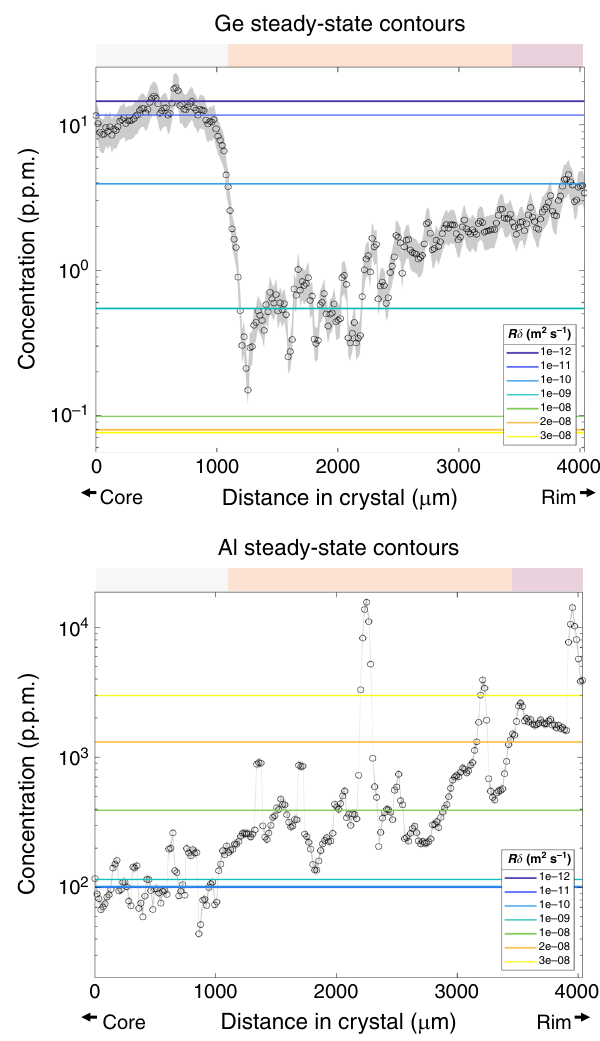
Fig. 6 Comparison of measured pro fi les with modeled steady-state concentrations. Steady-state concentrations calculated using Eq. 4 for different R δ and a constant D of 8 × 10 − 9 m 2 s − 1 for both Ge and Al. Data from both Ge and Al towards the core of the crystal correspond to similar R δ , suggesting steady-state growth in the core. Beyond the core region, Ge and Al give different R δ , suggesting a transient state. The lower R δ values (10 − 10 to 10 − 12 m 2 s − 1 ) in the Al plot are nearly identical, causing them to plot on top of one another. Horizontal color bar corresponds to CL color regions. Error envelopes represent standard error of the mean based on 3 σ of point analyses and a three-point moving average. The error values are 26% and 8.5% for Ge and Al,